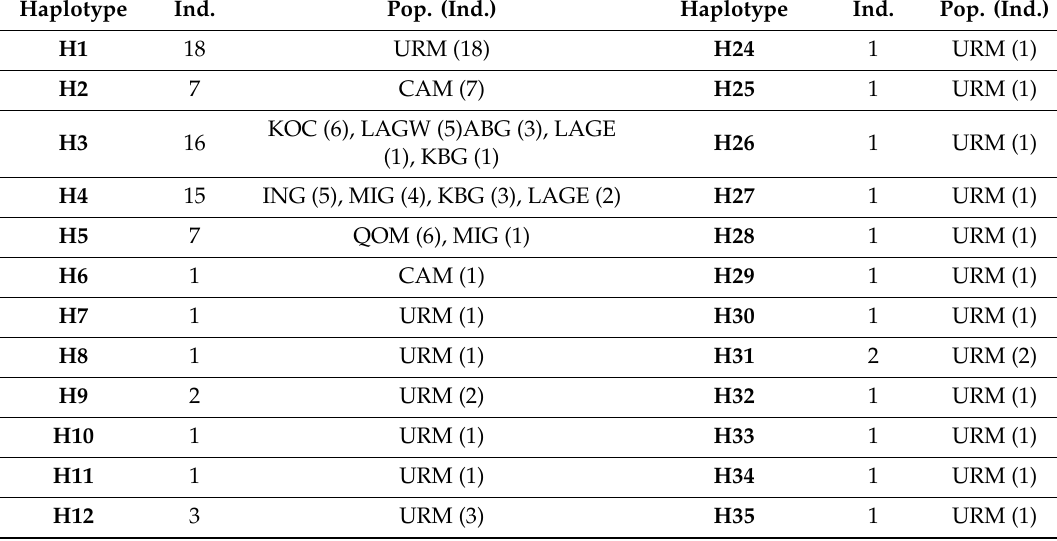
Table A1. Information of network haplotype composition of native populations. Haplotype